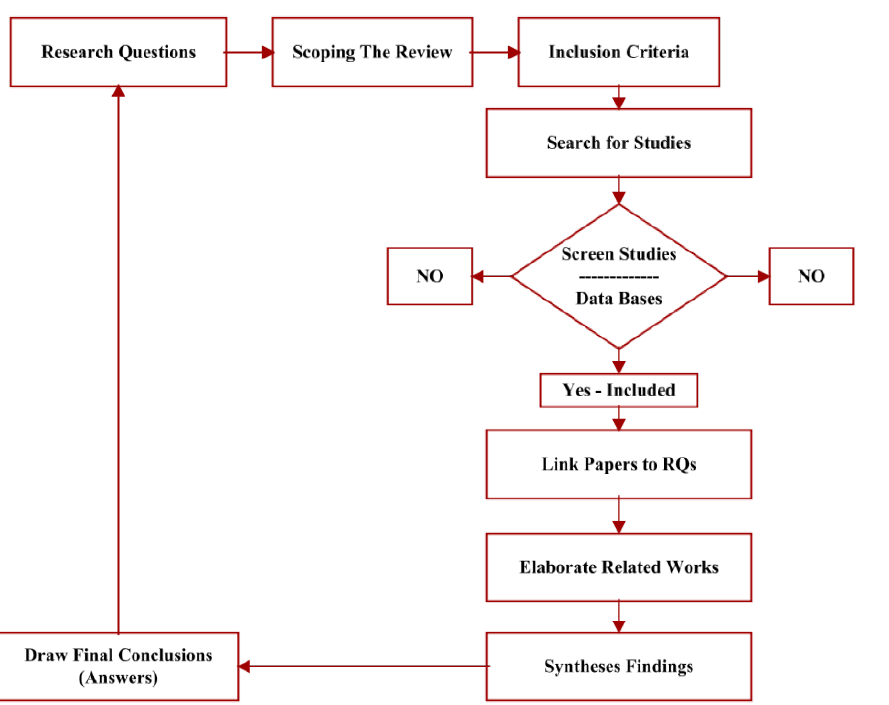
Figure 1. Various phases of the reviewing procedures. Source: Own elaboration.